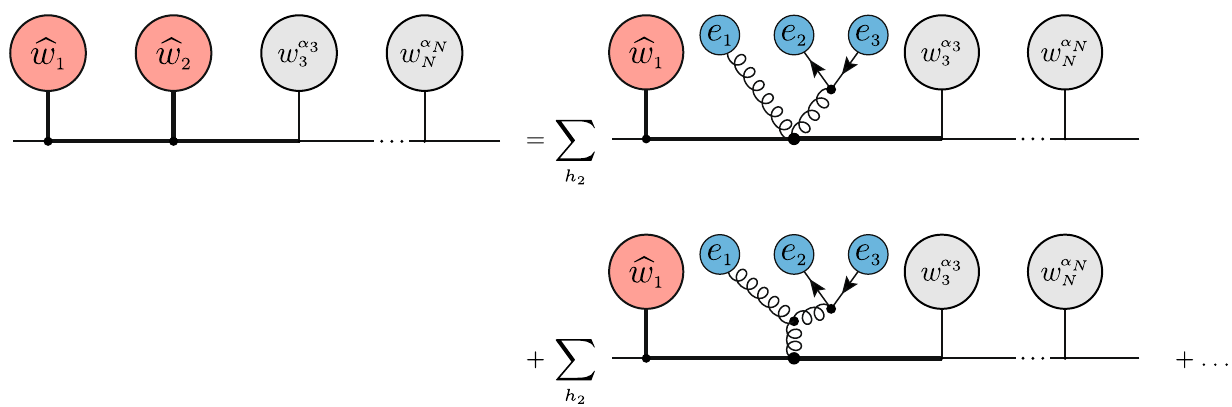
Fig. 5 Example of a step of the diagram merging recursion (73). After dressing the second segment and summing over its helicity configurations h 2 , all diagrams with equivalent one-loop topology and identical undressed segments S α 3